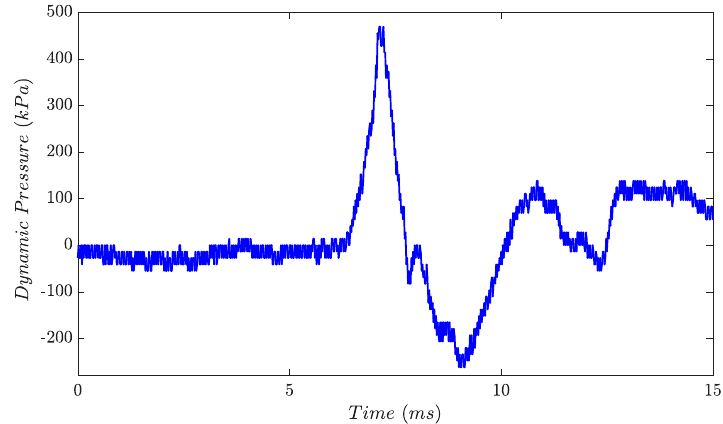
Figure 4. Pressure curve example for a valve opening time of 3.5 ms and a pressure of 69 mbar during an experiment with Copper (T = 1150 °C).